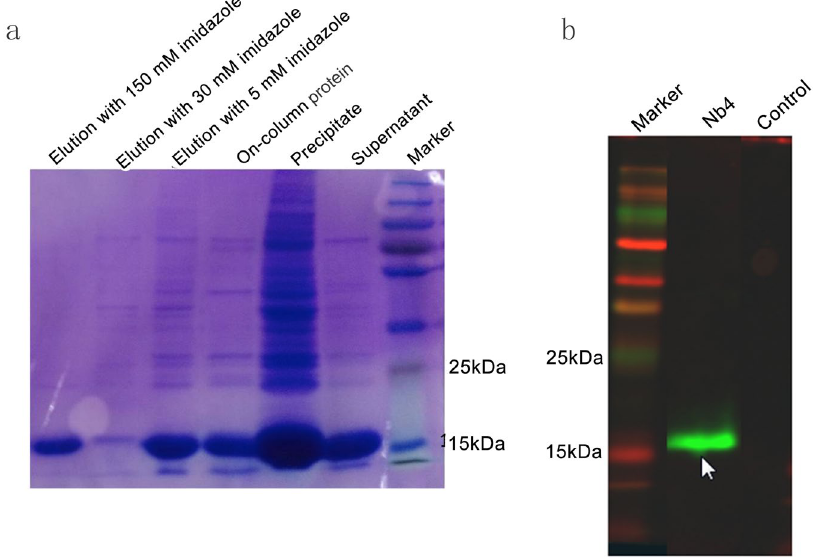
Figure 3. Expansion and characterization of Nb4. ( a ) Image of SDS-PAGE gel showing protein contents of different collections during Nb4 purification. The molecular weight of Nb4 is approximately 19 kDa. Nb4 was expanded by culturing bacteria that expressed Nb4 and purified. The supernatant, bacterial pellets, and different elution fractions were loaded on SDS-PAGE gel. ( b ) A representative image of Western blot to detect purified Nb4. Purified Nb4 was loaded on the SDS-PAGE gel and then transferred to a PVDF membrane. The membrane was probed with the primary antibody anti-His-FITC (Beijing CW Biotechnology Ltd.